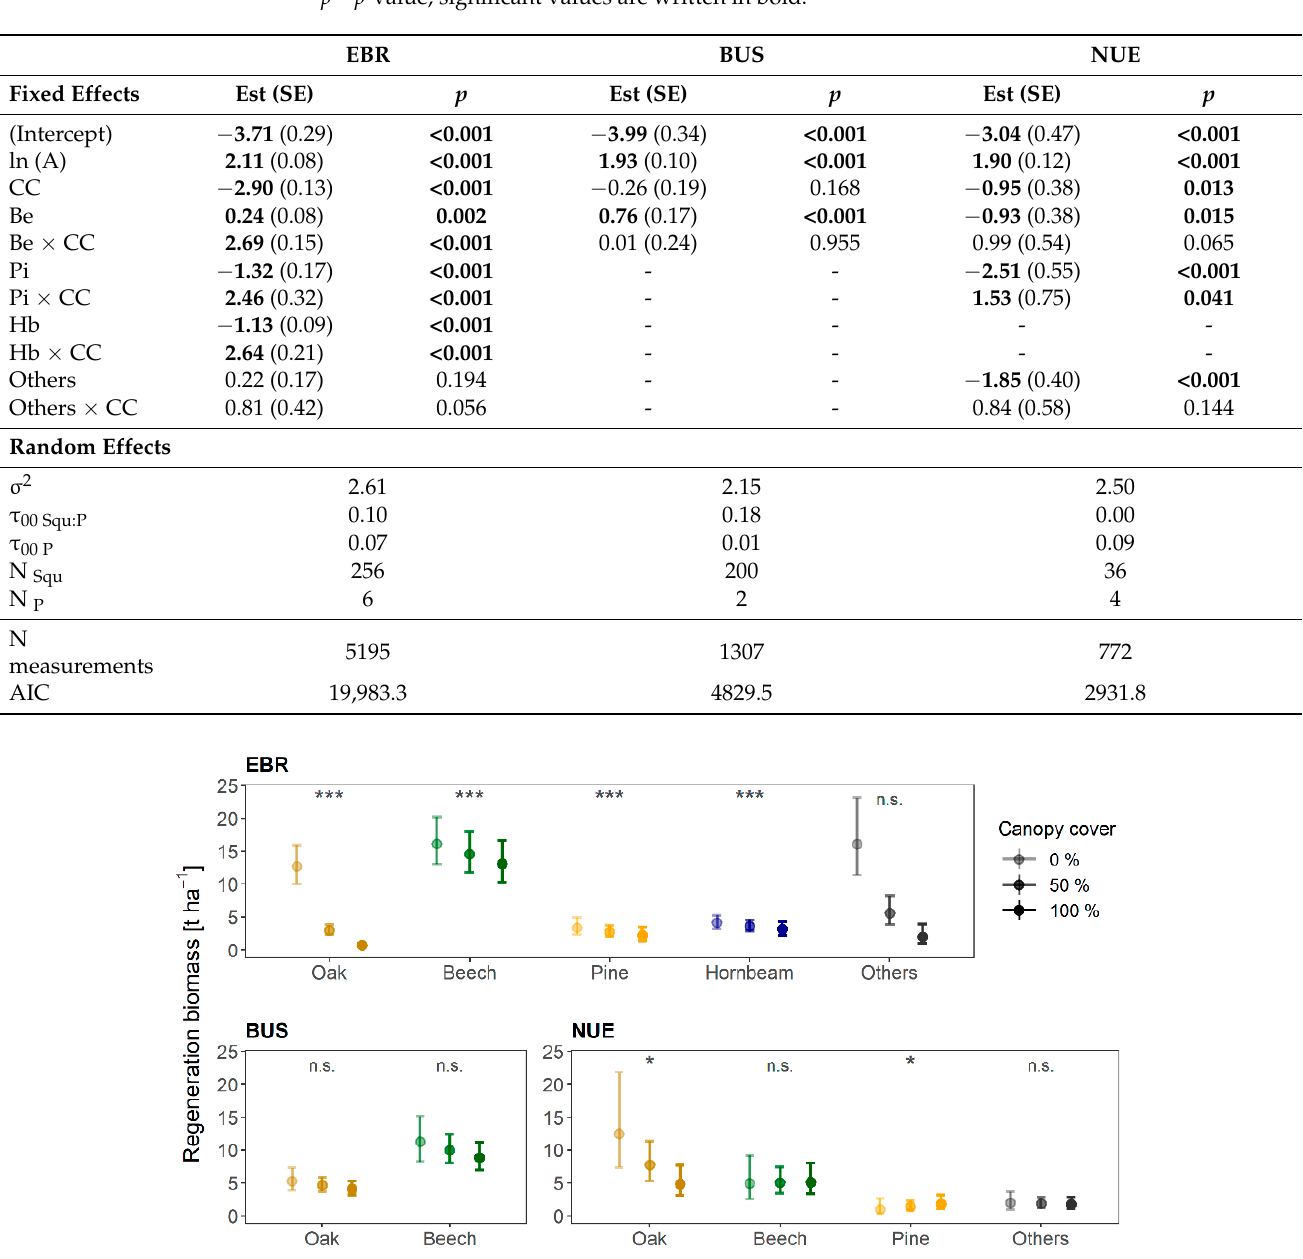
Table 5. Model statistics for biomass development as a function of regeneration age (A) and canopy cover (CC) (Equation (4)); the reference tree species is oak; Est—estimated value; SE—standard error; p — p -value; significant values are written in bold.